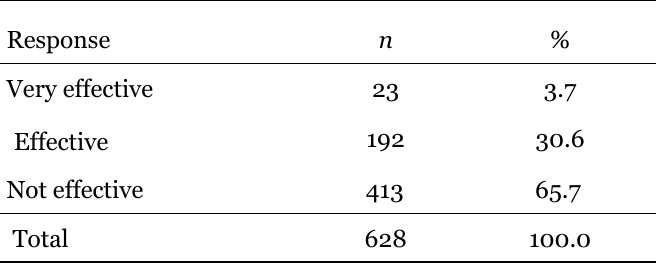
Students Response on the Use of Resource Centres